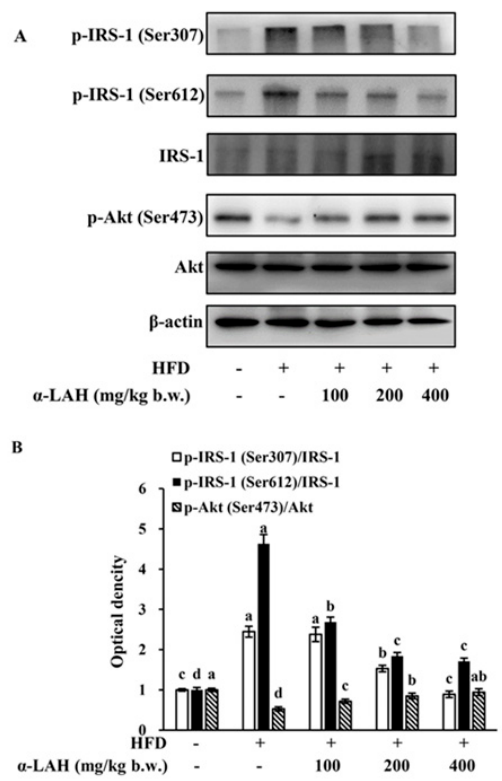
Figure 4. Effect of bovine α -lactalbumin hydrolysates ( α -LAH) supplementation on expression of insulin signaling markers in epididymal adipose tissues of mice fed with high-fat diet. ( A ) a representative image of western blot analysis for phospho-insulin receptor substrate 1 (p-IRS-1) and p-Akt in epididymal adipose tissues; ( B ) fold change in relative densitometric levels of p-IRS-1/IRS and p-Akt/Akt relative to the ND group. All data were presented as means ± standard deviations (SD) ( n = 6). Significance was determined by one-way analysis of variance (ANOVA) with the Duncan’s multiple-comparison test, and mean values without common letters indicate differences at p < 0.05.